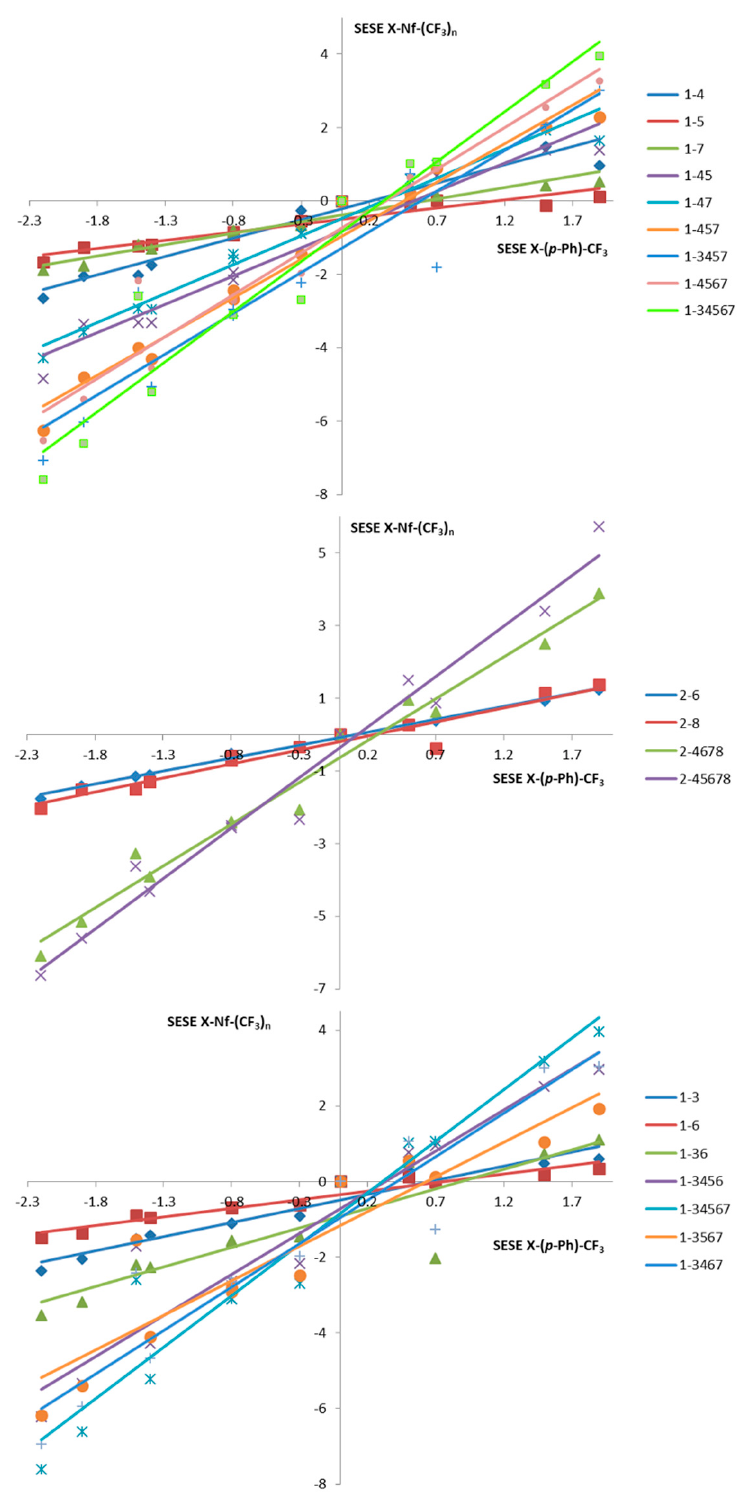
Figure 4. Comparison of dependences of SESE values of analyzed probes on SESE values of p ‐ substituted benzene derivatives X ‐ ( p ‐ Ph) ‐ CF 3 for selected types of naphthalene derivatives.